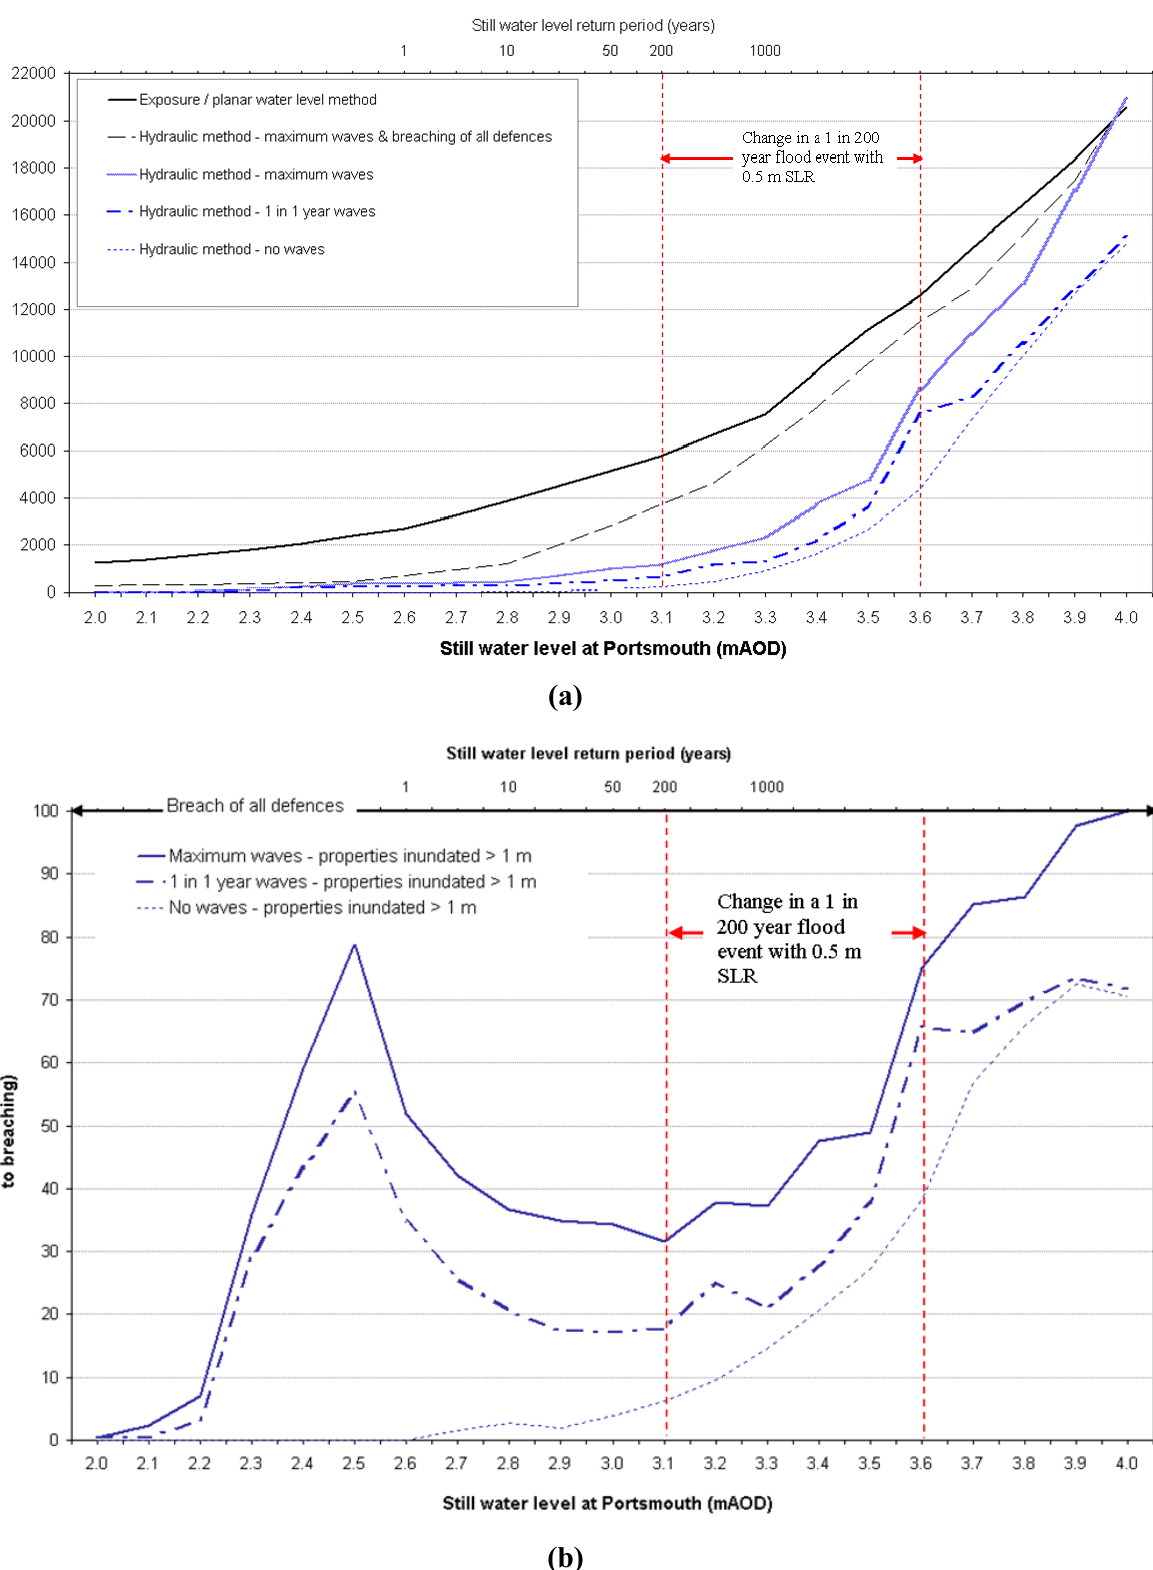
Figure 10. ( a ) The number of properties in the Solent inundated to a water depth of greater than 1 m; ( b ) Percentage of properties inundated to greater than 1 m water depth by overflow and overtopping defence failures (compared to breach of all